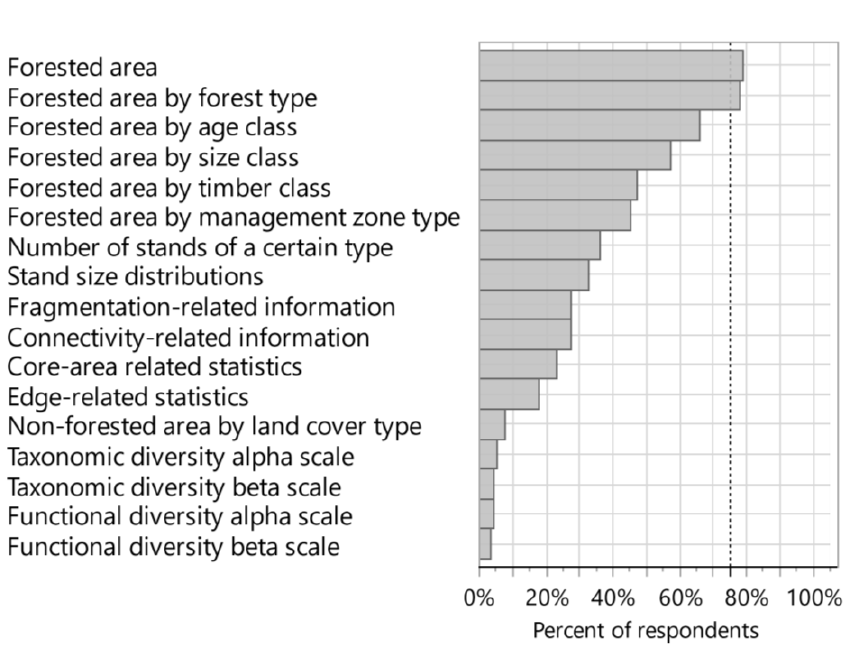
Figure 6. Landscape-scale variables for which forest managers would like information from wildlife scientists. Dotted line represents 75% of survey respondents.